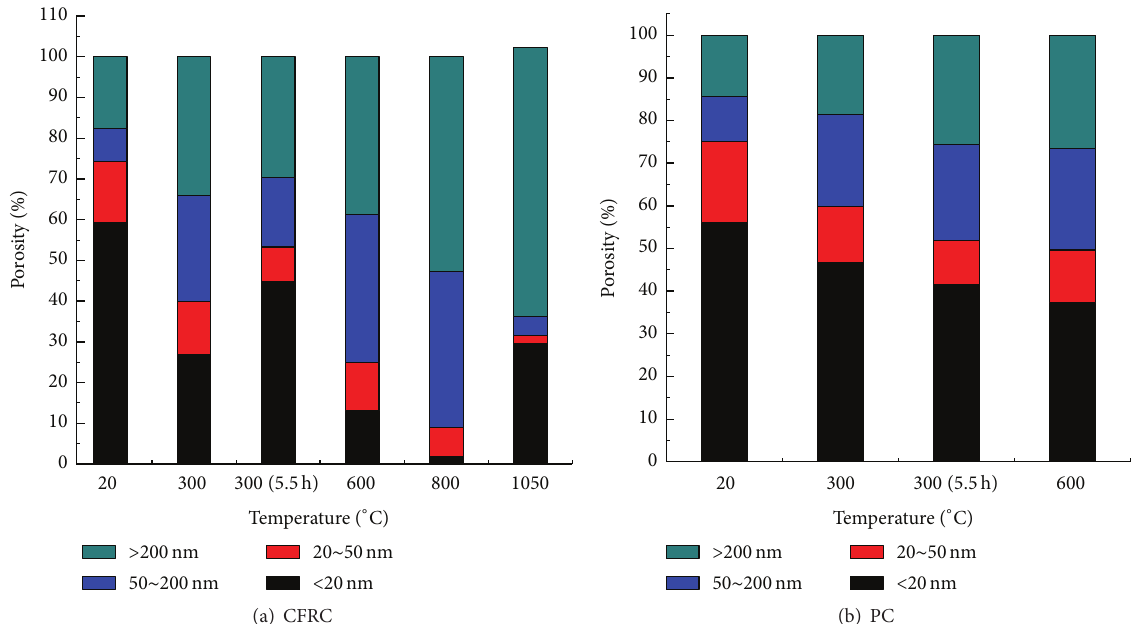
Figure 18: Influence of temperature on pore size in CFRC and PC samples.